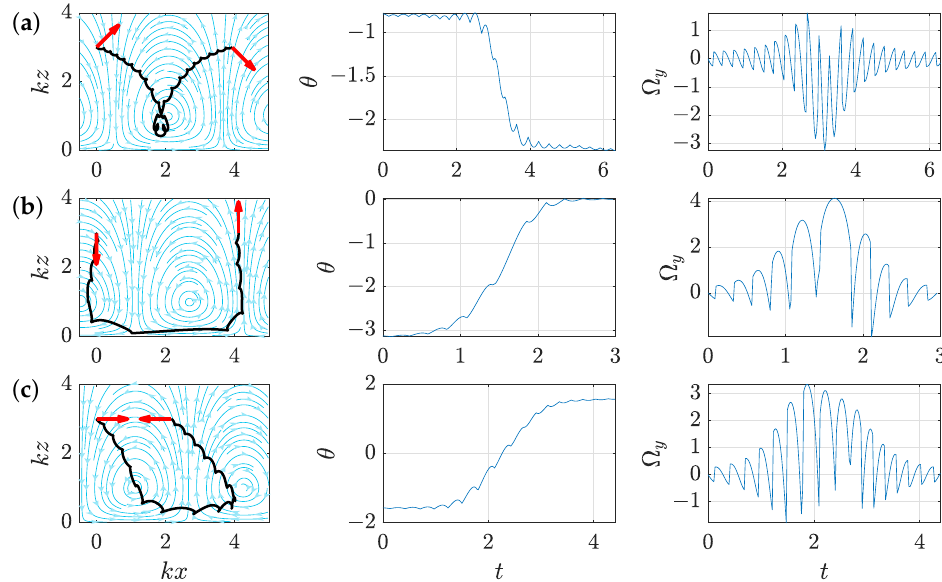
Figure 4. Time-optimal trajectories for changing the swimmer’s orientation with units of k = v = 1 as in Figure 3. In each row is displayed an optimal trajectory from an initial orientation θ 0 to a target orientation θ 1 , while remaining at a distance z 0 from the wall. The path followed in the xy -plane is shown on the left panel, while the evolution of the orientation θ with respect to time is shown on the middle panel, and the local rotational speed of the flow Ω y with respect to time is shown on the right panel. The values of initial and target orientation ( θ 0 , θ 1 ) for rows ( a – c ) are respectively given by ( − π /4, − 3 π /4 ) , ( − π ,0 ) , and ( − π /2, π /2 ) and represented by red arrows on the trajectory plots on the left. For each case, we can distinguish three phases: approach to the wall with little variation of θ , rotation close to the wall, and going away from the wall